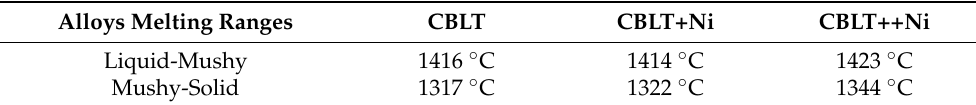
Table 2. Average values of the melting end and solidification start temperatures (temperature frontier between the mushy state and the liquid state) and of the melting start and solidification end (temperature frontier between the solid state and the mushy state); DSC curves, cycle 2. Alloys Melting Ranges CBLT CBLT+Ni CBLT++Ni Liquid-Mushy 1416 ◦ C 1414 ◦ C Mushy-Solid 1317 ◦